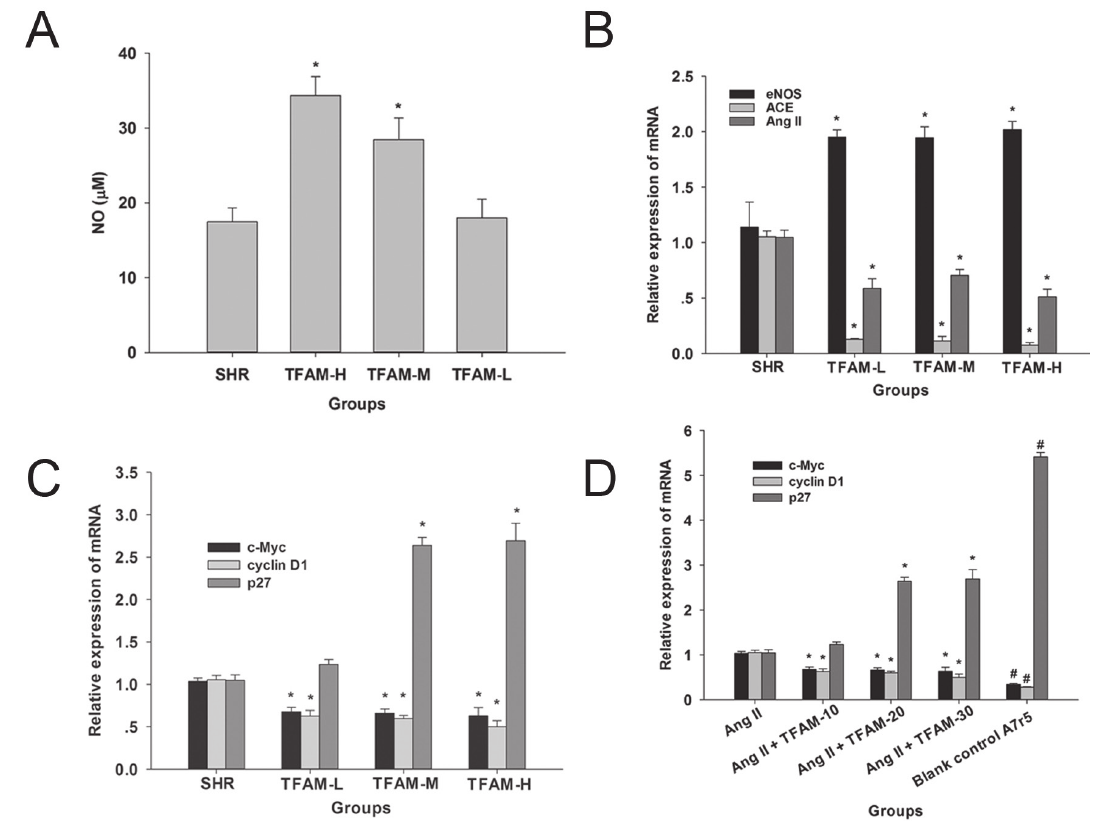
FIGURE 2 - Effects of TFAM on the serum nitric oxide level, and expressions of RAS and proliferation related genes in vascular smooth muscle cells. TFAM increased the release of nitric oxide in serum and altered the mRNA expressions of eNOS, ACE and Ang II. (A) The effects of TFAM on the content of nitric oxide. (B) The evaluation was estimated via qPCR analysis using mRNA from cells treated with TFAM and the process was described in Methods. (C) The effects of TFAM-L, TFAM-M, TFAM-H on the mRNA expressions of p27 Kip1 , c-Myc and cyclin D1 in the thoracic aorta of SHRs. The values in (A, B, C) given are the mean ± SD. n = 6, * P <0.05, compared with the SHR group. (D) The effects of TFAM (10-20μg/mL) on the mRNA expressions of p27 Kip1 , c-Myc and cyclin D1 in Ang II-stimulated A7r5 cells. Gene expression was estimated via qPCR analysis using mRNA from tissues or cells treated with TFAM and the process was described in Methods. The values given are the mean ± SD of three independent experiments. * P <0.05 and # P <0.05, compared with Ang II group in (D)